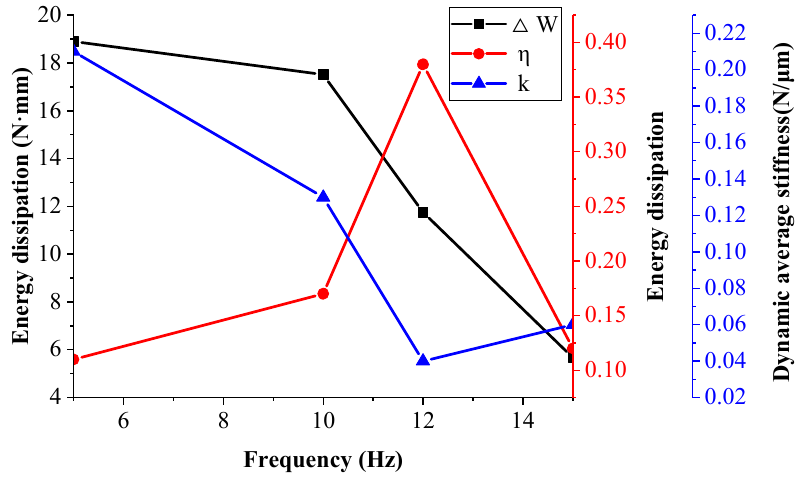
Figure 8. Test data processing results of group 1 (A = 0.5 mm).